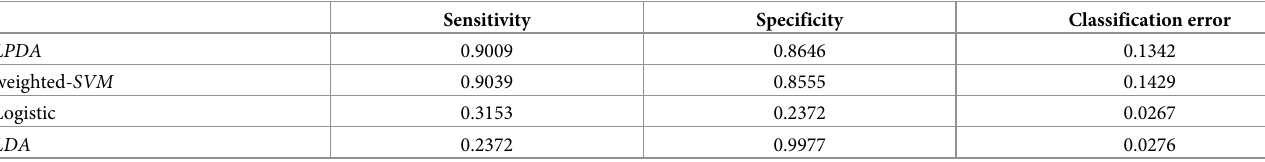
Table 1. Sensitivity, specificity and classification error for default